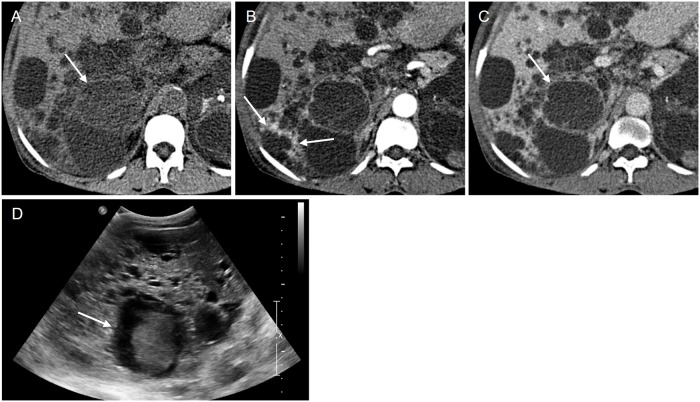
A 59-year-old female patient with an infected cyst (H12 in Fig 2).(A) The pre-contrast CT image shows a 5.5 cm sized cyst with a lobulated contour in segment 6 of the liver (arrow). The cyst appears to have a relatively high attenuation compared to the surrounding cysts. (B) The arterial phase image shows arterial hyperenhancement (arrows) in segment 6 of the liver; however, perilesional hyperemia could not be definitely diagnosed due to the intervening cysts between the lesion and hyperemia site. (C) The cyst shows discernible wall thickening in the portal venous phase. Of note, intracystic attenuation seems equal in contrast to the pre-contrast scan. (D) Ultrasonography shows a heterogeneous hyperechoic cyst with internal septation (arrow).